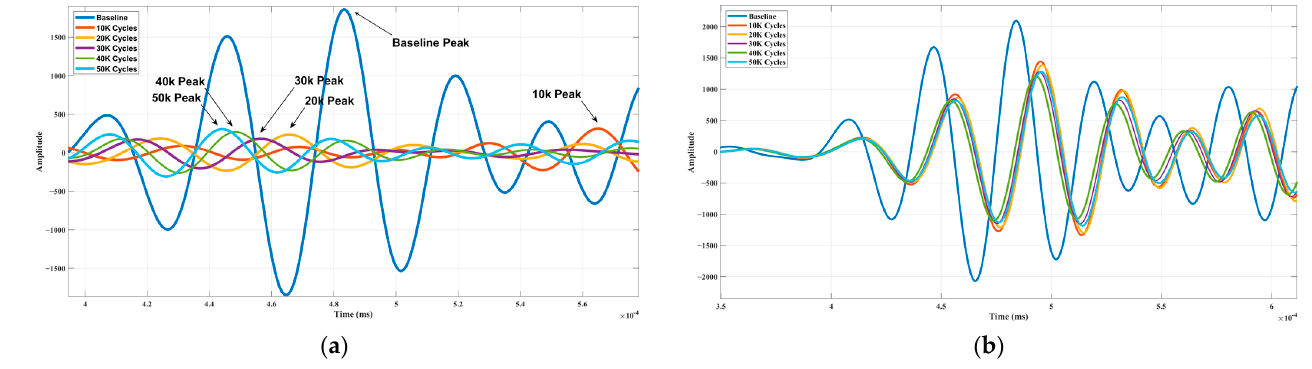
Figure 2. Time-domain signals for the ( a ) 5–10 and ( b ) 3–8 path.